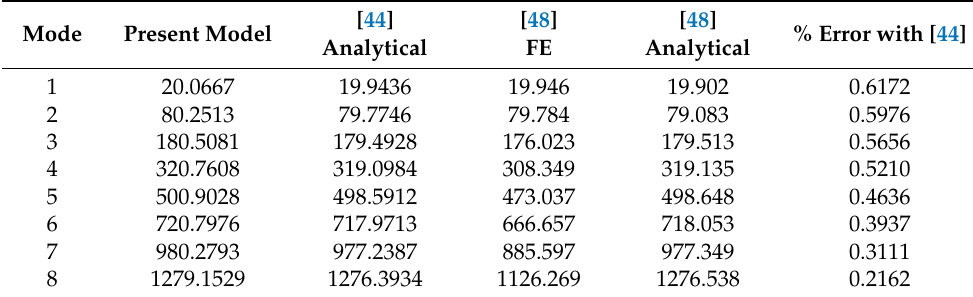
Table 3. Comparison of the estimated classical natural frequencies in Hz for the lowest eight vibration modes of SS sandwich beam in the absence of piezoelectricity effect for L = 1.2 m, h c = 10